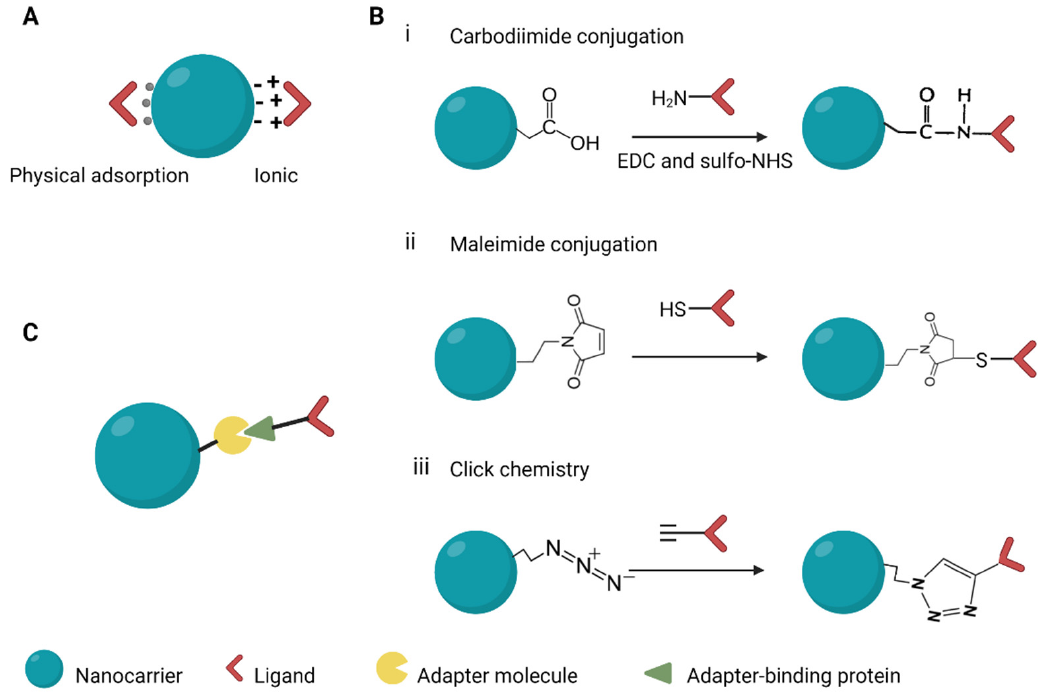
Figure 6. Methods used in conjugating ligands to nanocarriers. ( A ) Adsorption, ( B ) covalent conjugation, ( C ) use of adapters. EDC, 1-ethyl-3-(-3-dimethylaminopropyl) carbodiimide; sulfo-NHS, N-hydroxysulfosuccinimide. Created with BioRender.com.